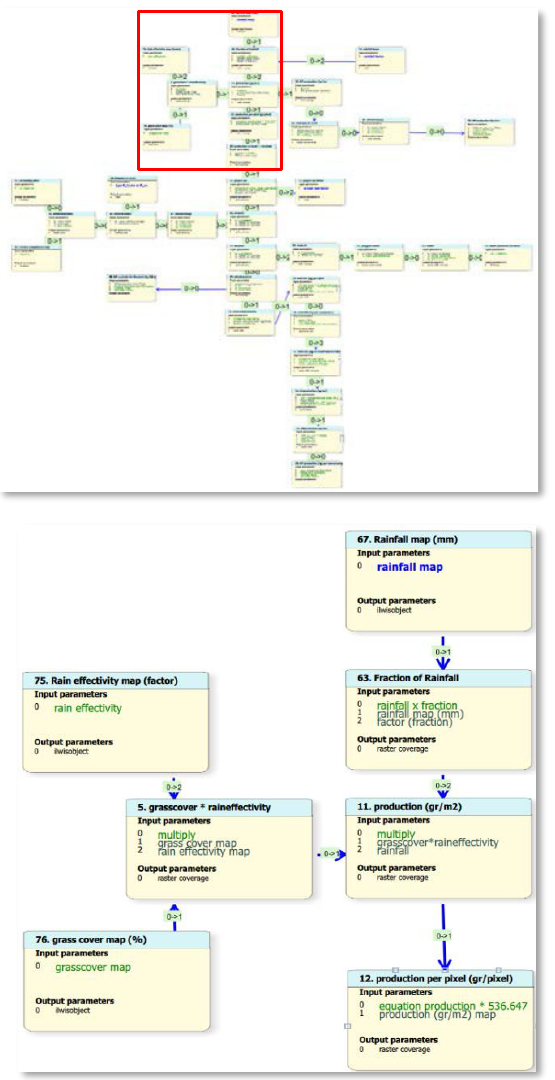
Figure 5. The ILWIS 4 production workflow (overall and an enlarged